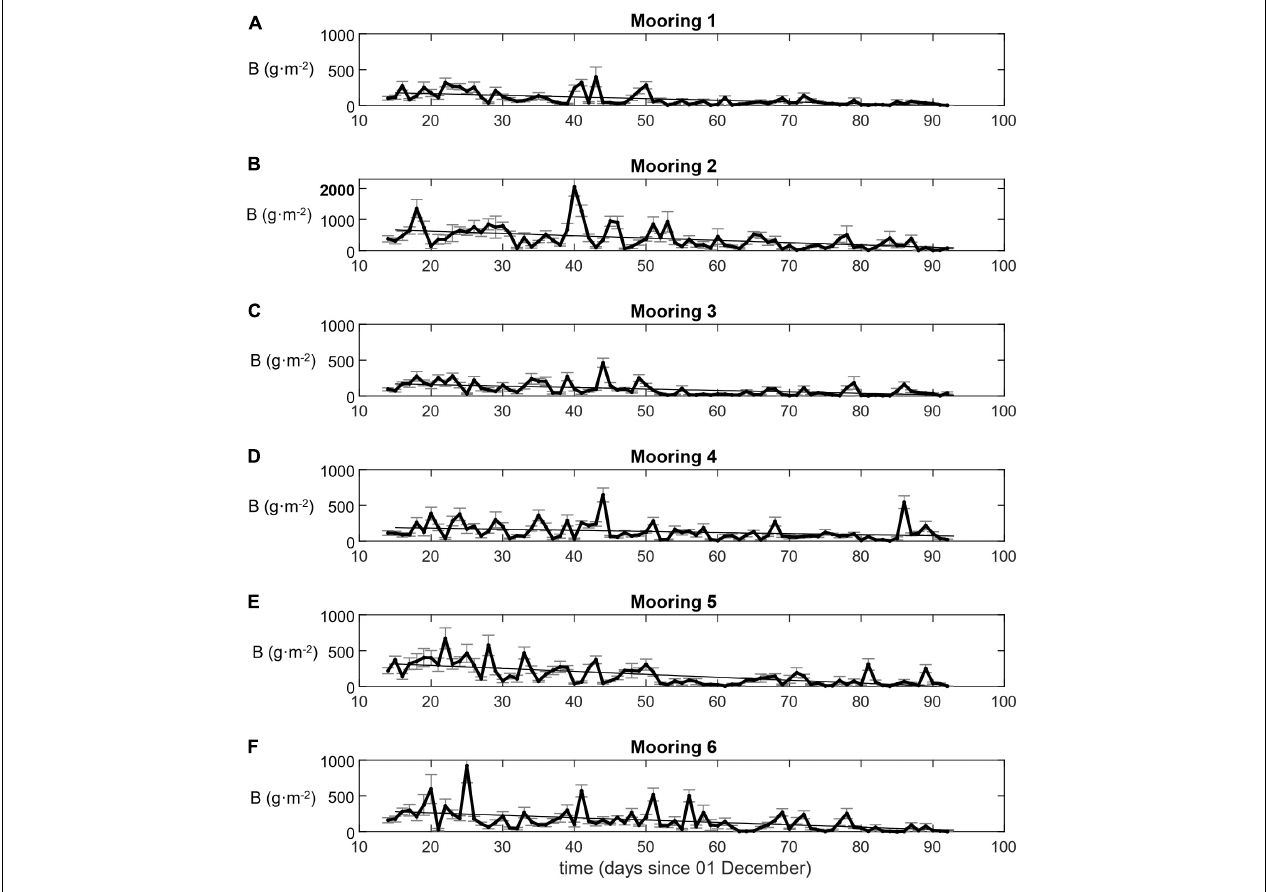
FIGURE 7 | Krill biomass density B (g · m − 2 ) by Mooring (1–6: A–F ). Vertical axis scale maximum is 1000 except for Mooring 2 which is 2000.